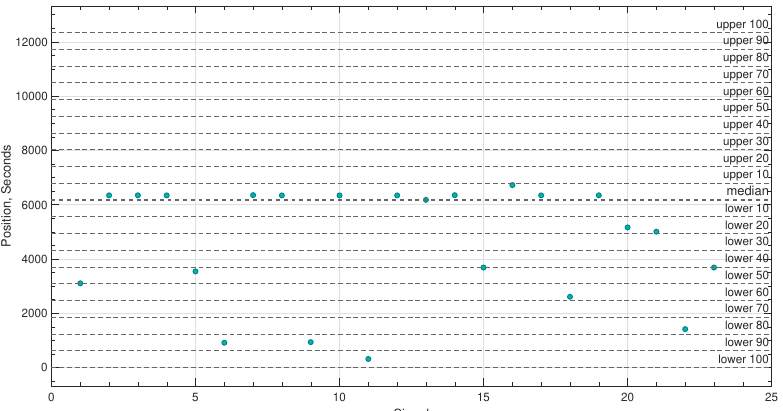
Figure 3. This figure shows an example of a logical true classification process used to identify abnormal activity. The y-values represent the position of the maximum PLV values in seconds and the boundaries represent the constraint ρ . In this case, abnormal activity is found.